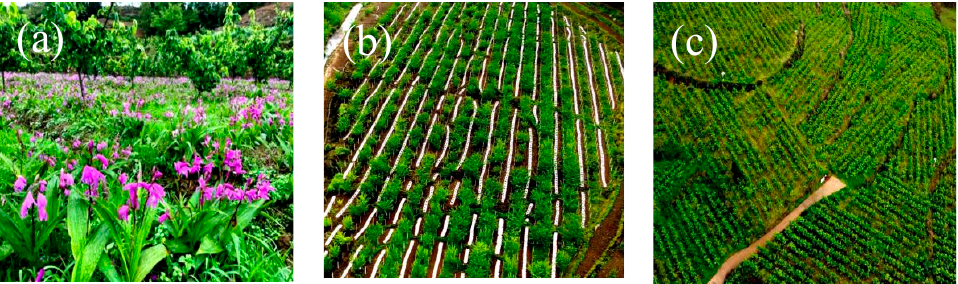
Figure 7. Typical AF in the buffer zone of WH karst (( a ): Pear + Bletilla; ( b ): Plum + Passion fruit; ( c ): Pear + Miltiorrhiza).